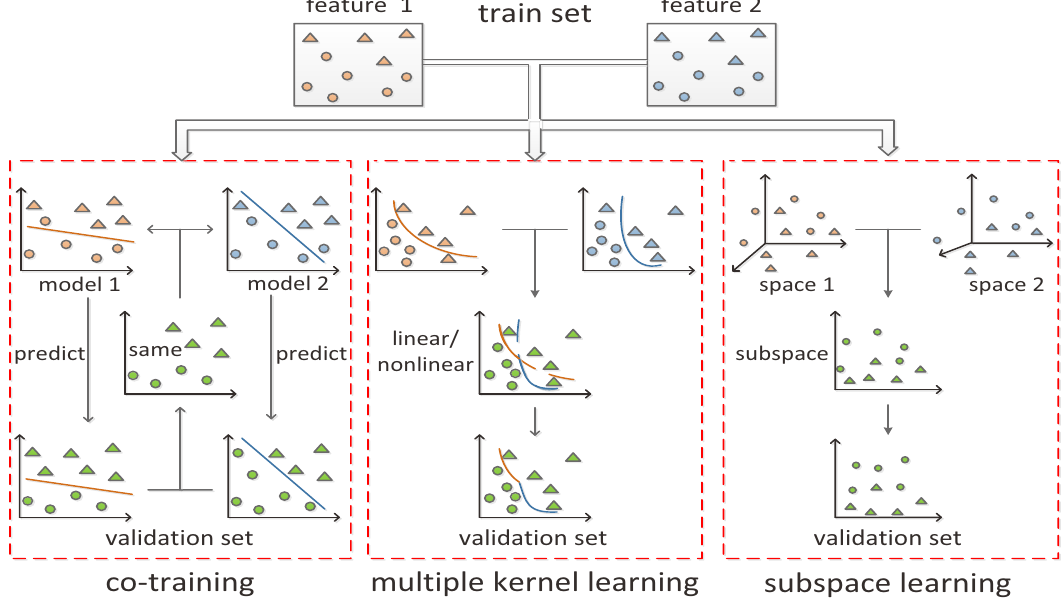
Figure 1. Sketches of co-training, multiple kernel learning and subspace